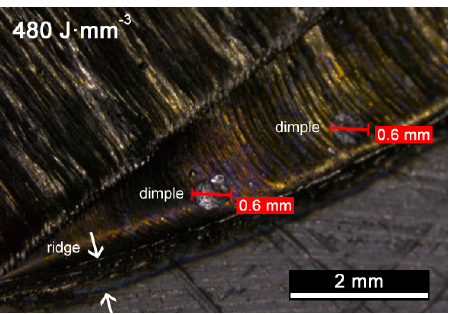
Figure 3. Ridges and dimples at the contour of the cross ‐ section, for VED of 480 J ∙ mm − 3 .